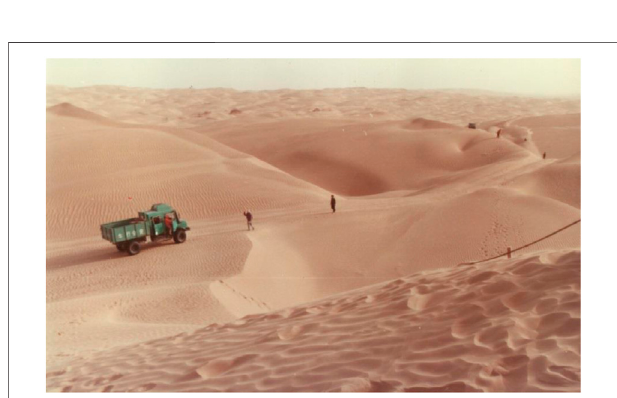
FIGURE 2 | Desert truck carrying goods and supplies before 1995 through the shifting sand